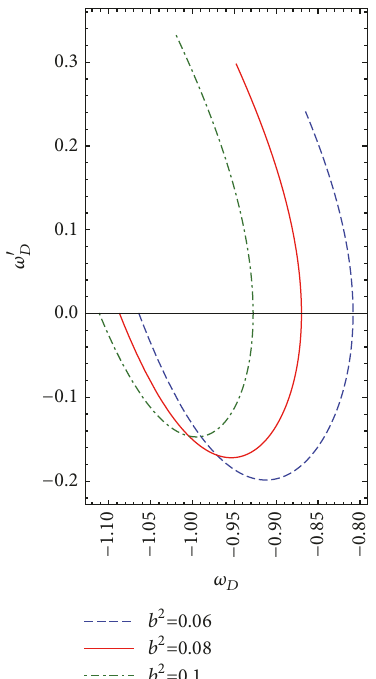
Figure 18: The 𝜔 𝐷 − 𝜔 󸀠 𝐷 diagram for interacting GDE in the DGP model. Here, we have taken Ω 𝐷 (𝑧 = 0) = 0.73 , 𝐻(𝑧 = 0) = 67 , and Ω = 𝑟 𝑐